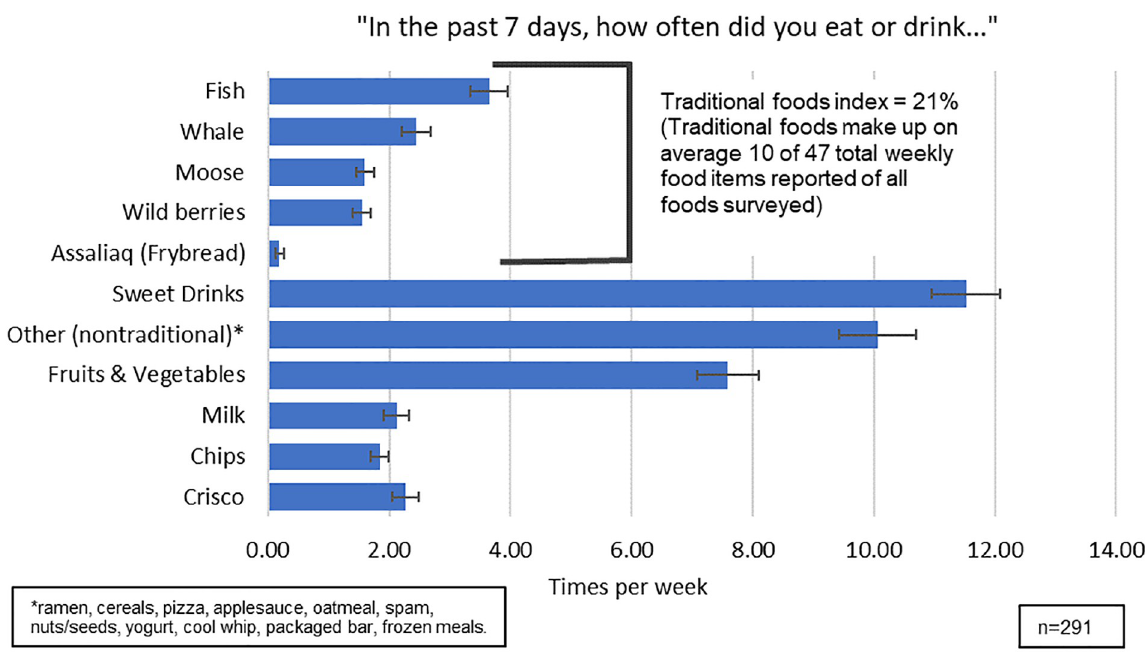
Fig 1. Participants’ most frequent foods consumed, shown as times per week and grouped as traditional and